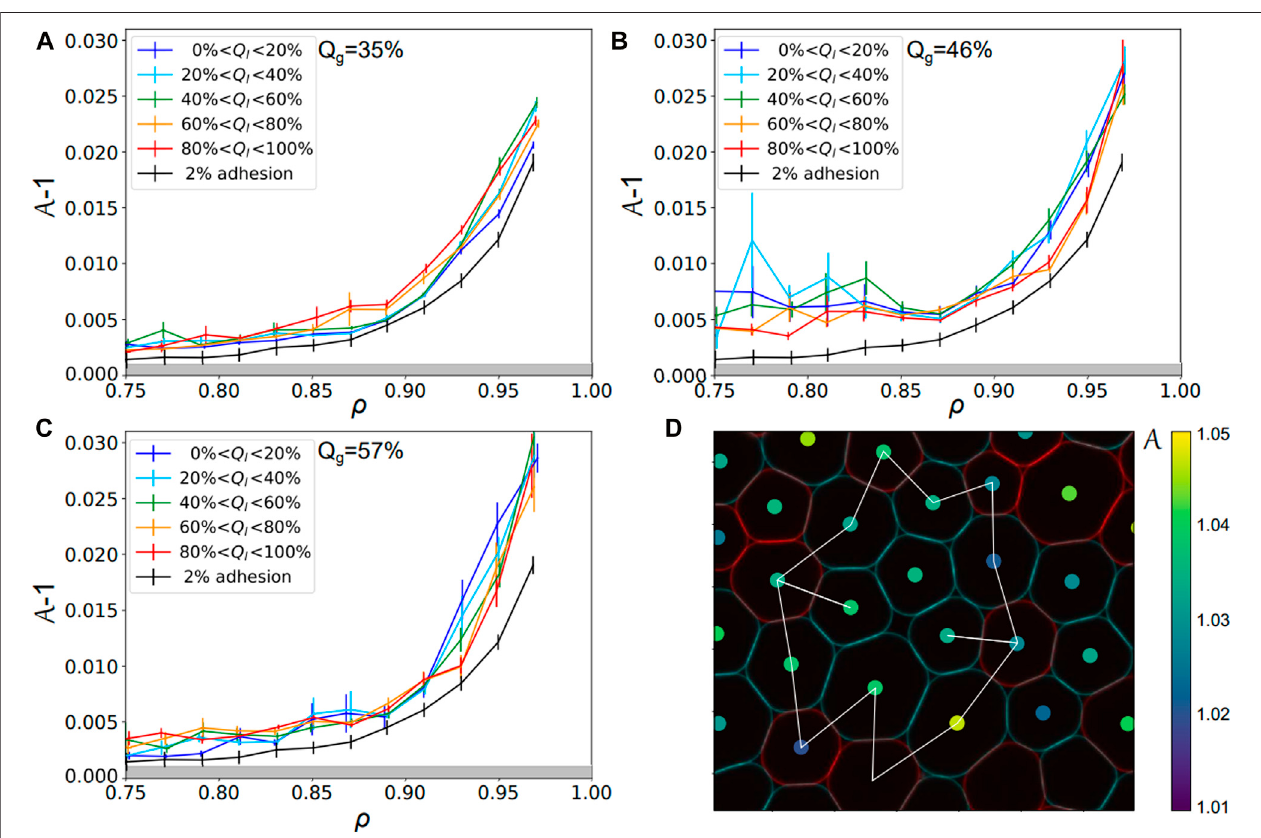
FIGURE6| Droplets localadhesiveness forvarious globaladhesion conditions — Shapefactor A − 1asafunctionoflocalpackingfraction plottedfor differentbins of local adhesiveness Q l in DNA packings yielding a global adhesiveness Q g (cid:1) 35 % (A) , Q g (cid:1) 46 % (B) , and in streptavidin packings yielding Q g (cid:1) 57 % (C) . (D) Confocal image of a DNA complementary droplets packing ( Q g (cid:1) 46 % ) in which a central (blue) droplet exhibits fi rst neighbors of the same color (blue), and therefore has a local adhesivenessof0.However,onecandrawacontinuousringofadhesivecontactsinfartherdropletsbydrawingapathofcontactsbetweenredandbluedroplets. Image size: 219.6 μ m × 184.3 μ m.